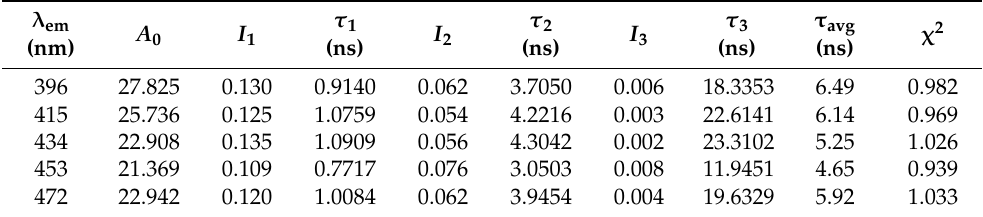
Table 1. Exponential reconvolution fitting parameters of the PL decay curves of undoped SrAl 2 O 4 at different emission wavelengths ( λ em ). The excitation is the 320 nm pulsed light with a pulse period of 100 ns. λ em A 0 I 1 (nm)